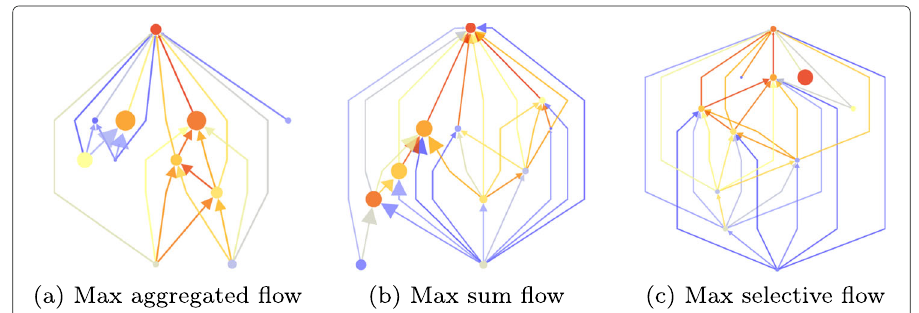
Fig. 15 The induced subgraphs of the top publication identified by each of the three multiplex flows, in the subset (#citations=10, h -index=6). The size of nodes correspond to their number of citations, the size of edges correspond to their number of co-citations. The color of nodes and edges correspond to the flow measures transiting through each node/edge ( a : aggregated, b : sum, c : selective), minimum is blue , maximum is red . In the case of the sum and selective flow, we can notice clear differences between node size and color mapping emphasizing the differences between the flow measures and the #citations